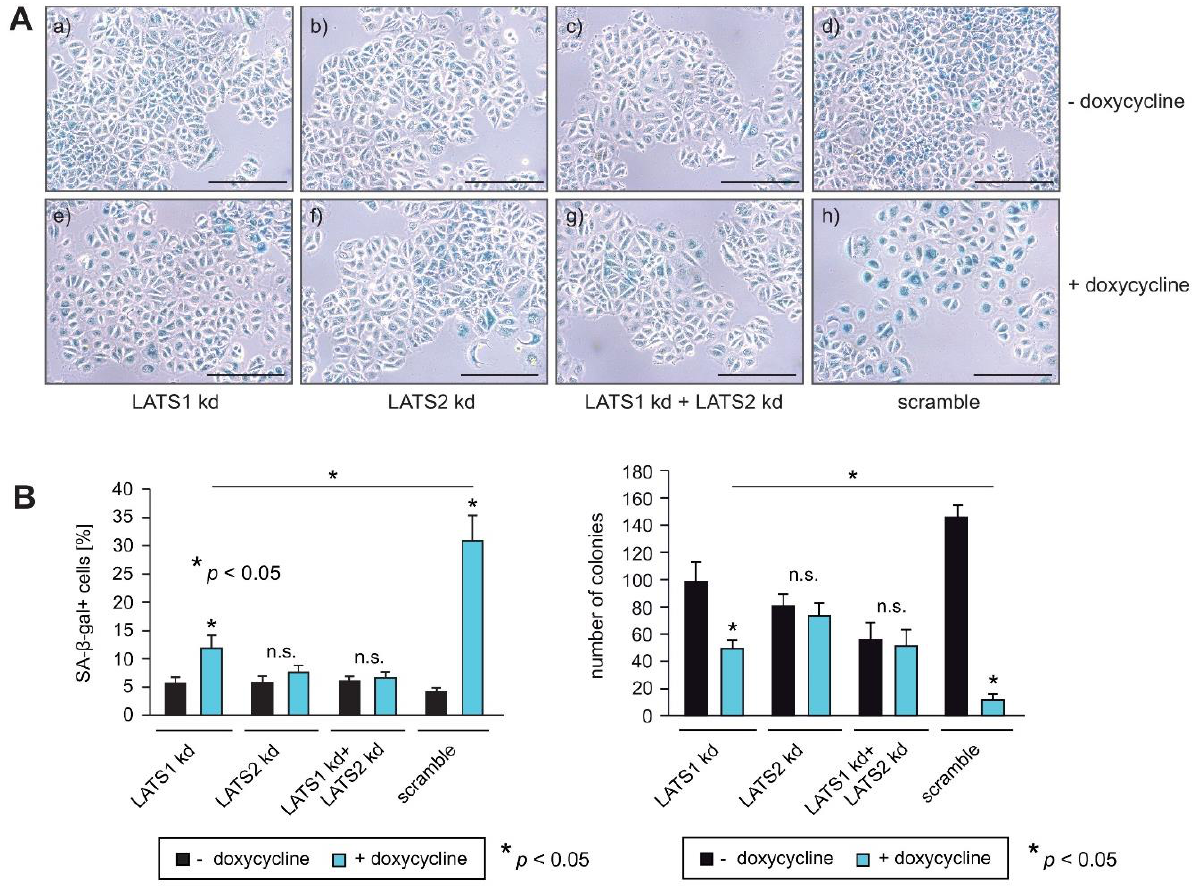
Figure 5. Knockdown of LATS1 and LATS2 circumvent RASSF1A-mediated induction of senescence. ( A , B ) RASSF1A- induced senescence in conditional RASSF1A MCF7 scramble, LATS1 kd, LATS2 kd and LATS1+LATS2 double knock- down cells was monitored by SA- β -gal staining (right panel). Cells were cultured in the absence (a – d) or presence of 1 µg/mL doxycycline (e – h) as indicated. Bars = 100 µm. ( B ) Quantification of senescent cells was achieved by counting (left panel). Mean values ± s.d. of three independent experiments are shown. p -Values < 0.05 are indicated by asterisks.